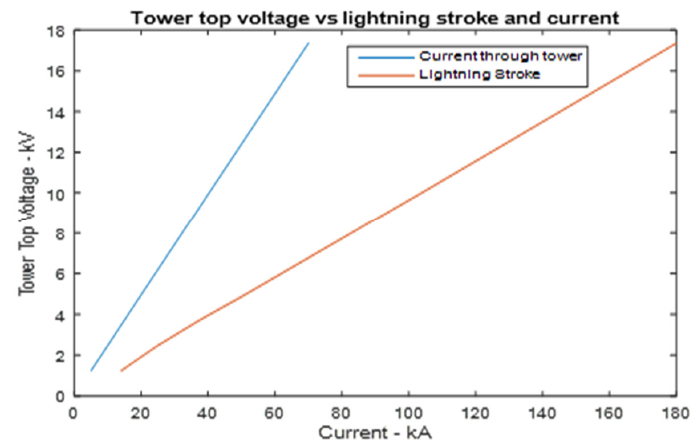
Figure 13. Top Tower voltage vs. lightning current through the tower.